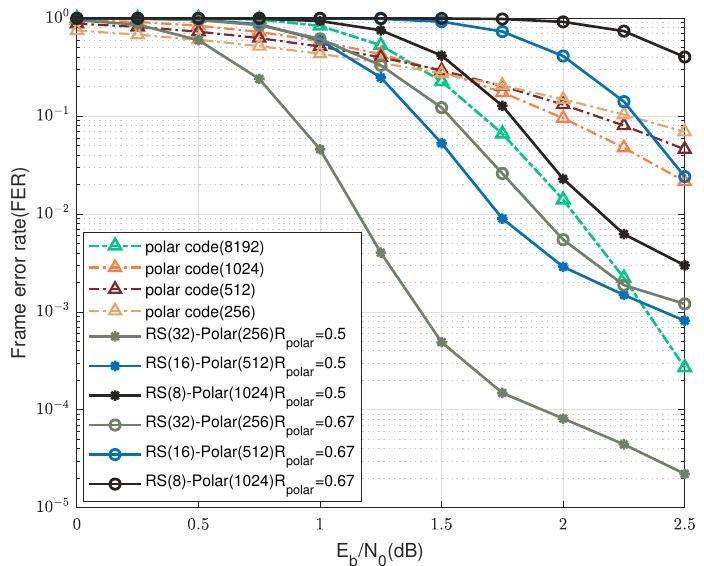
Figure 11. Comparison between the UEP-RS-polar product codes and the SC decoding of single polar codewords over GE channels for R tx ≈ 1/4, P GG = 0.9 and R polar = 0.5,